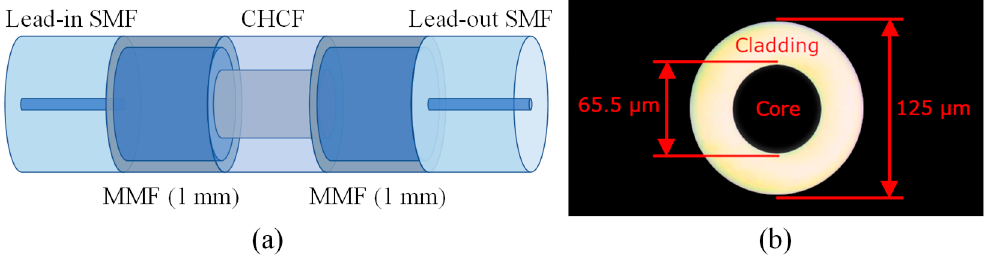
Figure 2. ( a ) Schematic drawing of an MZI based on one section of CHCF and two sections of MMFs (1 mm); ( b ) Cross- section of the CHCF.